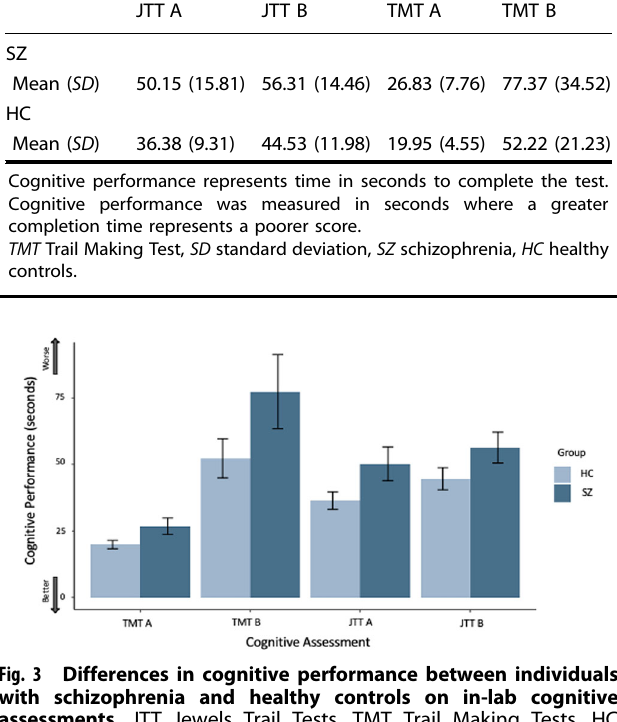
Table 2. Means and standard deviations for cognitive performance in schizophrenia and control groups on in-lab JTT and TMT at baseline.